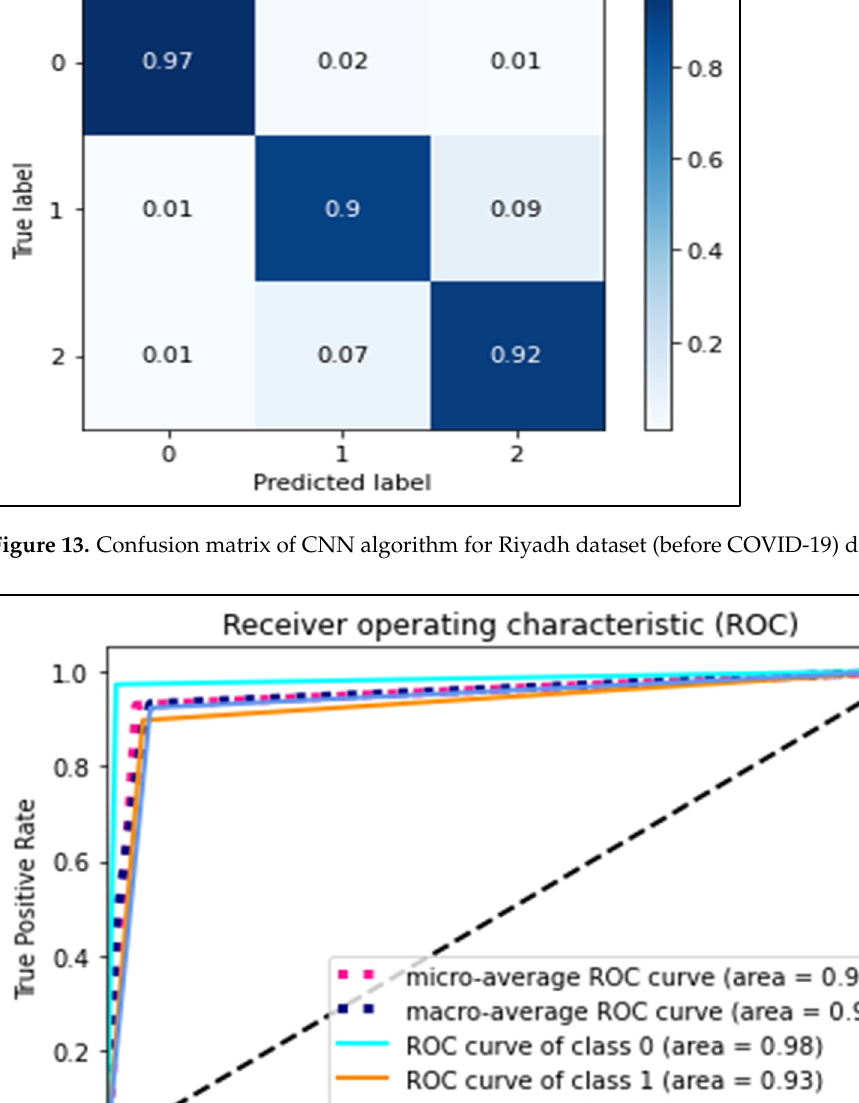
Figure 14. ROC curve of the CNN algorithm for Riyadh dataset (before COVID-19) dataset.